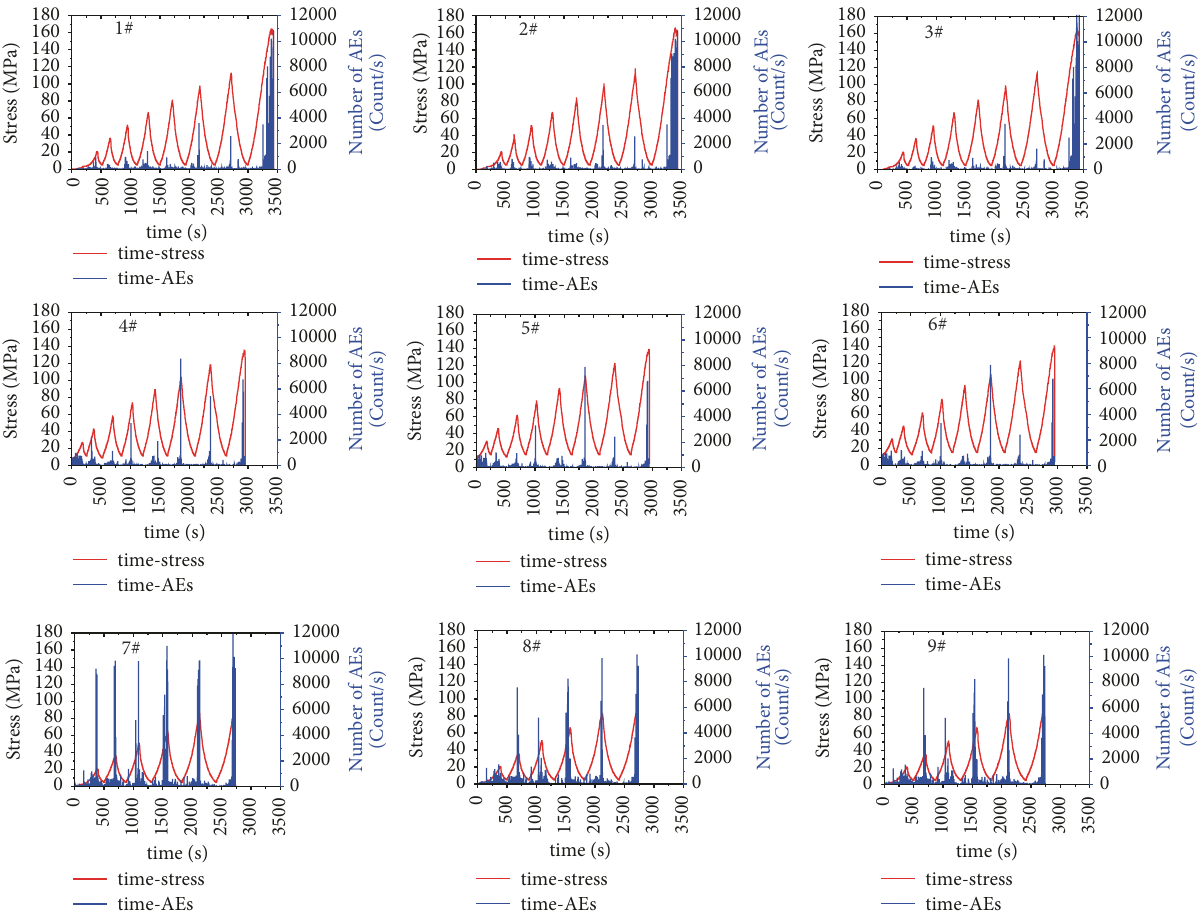
Figure 10: AE counts and stress of the tested specimens versus